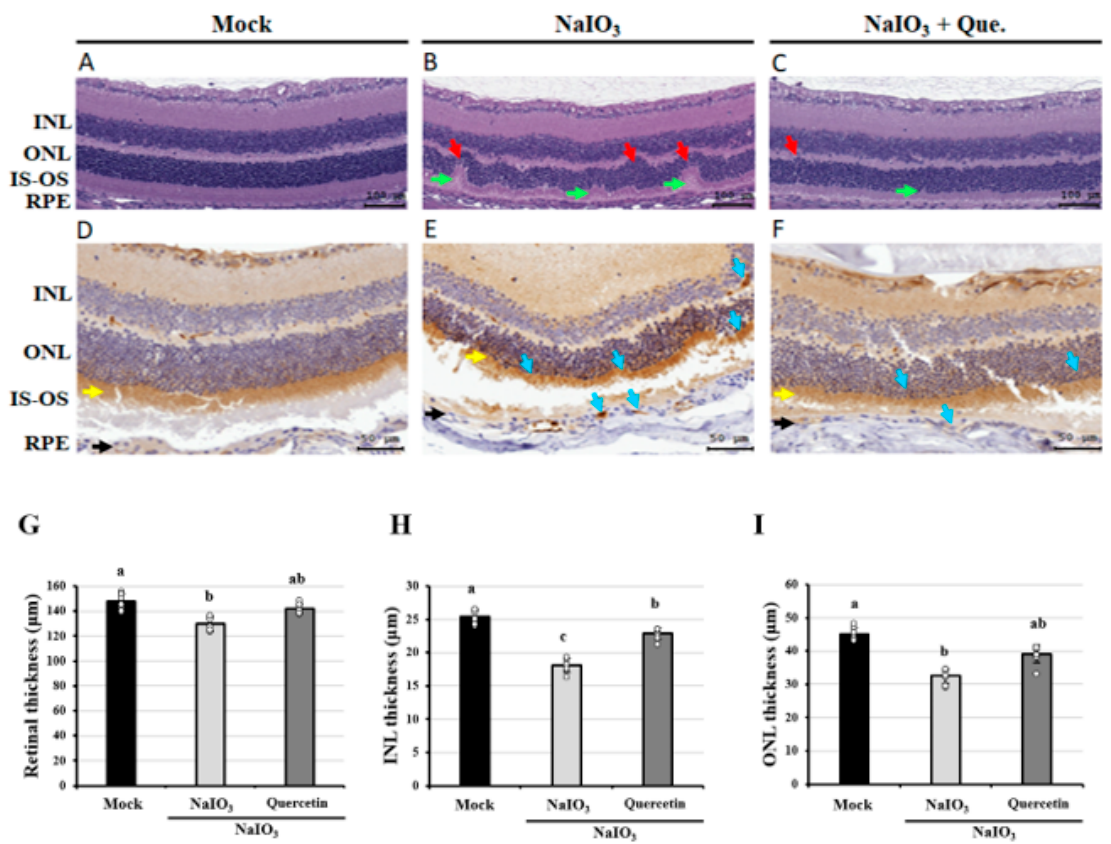
Figure 1. Quercetin improved the NaIO 3 -induced retinal degeneration and attenuated NaIO 3 -induced autophagy in mice retina. Eyeballs were harvested and subjected to H&E staining to assess retinal conformation and IHC staining for the expression of LC3 antibody 7 days after NaIO 3 treatment in each group, including the ( A , D ) mock, ( B , E ) NaIO 3 , and ( C , F ) NaIO 3 + quercetin-treated groups. H&E staining ( A – C ) showed conformational and thickness changes of the retina, inner nuclear layer (INL), outer nuclear layer (ONL) (red arrows), and inner and outer segments of the photoreceptor layer (IS-OS). Arrows in green indicate the formation of drusen-like lesions. Scale bar = 100 μ m. Positive staining for LC3 ( D – F ) is shown in brown, and the yellow and black arrows indicate photoreceptor and RPE layers, respectively. Scale bar = 50 μ m. ( G – I ) Retinal ( G ), INL ( H ), and ONL ( I ) thicknesses were measured at six locations and the values were then averaged. Values represent the mean ± SD ( n = 8, 8 individual set experiments per set of groups). The letters a, b, and c indicate statistically significant difference ( p < 0.05).